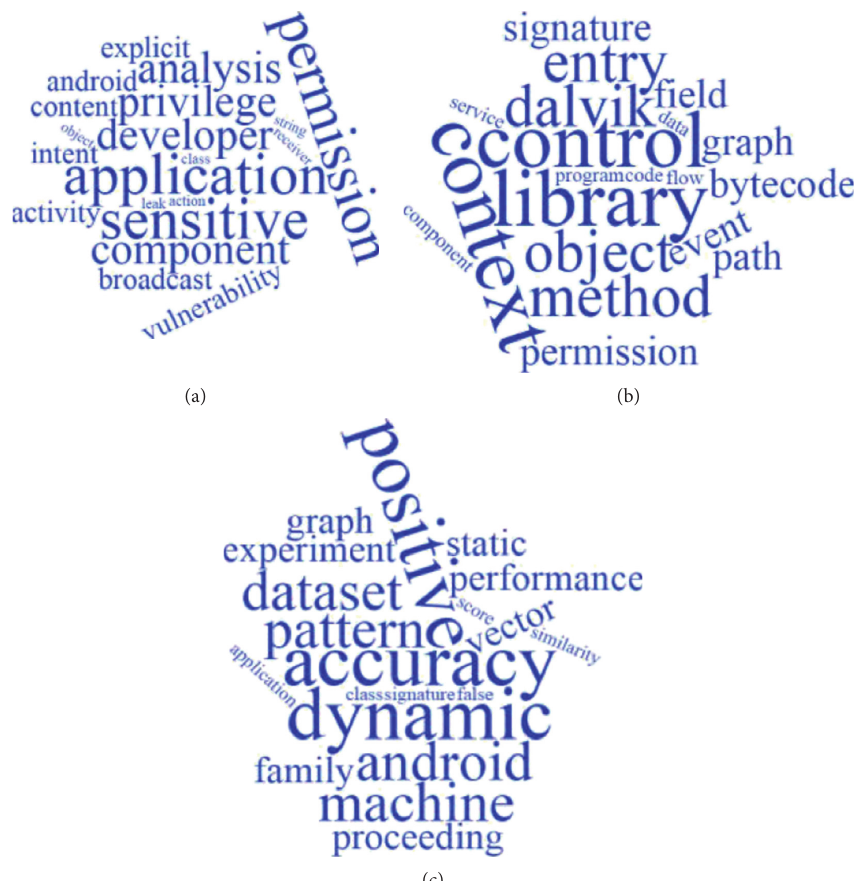
Figure 14: Word clouds generated by TRENDMINER for three topic solution (a)–(c). (a) Word cloud of topic solution 3.1. (b) Word cloud of topic solution 3.2. (c) Word cloud of topic solution